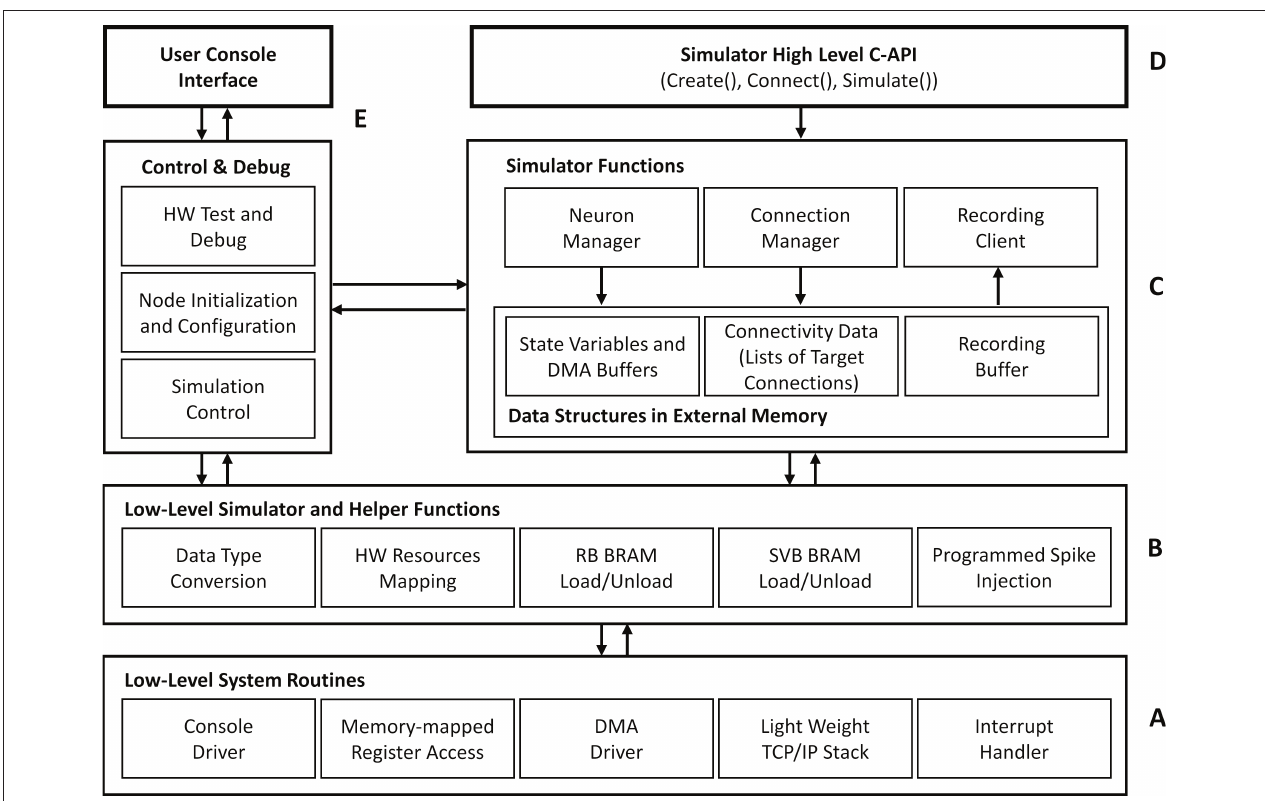
FIGURE 7 | HNC node software system architecture. The tiered architecture provides abstraction at different functional levels. (A) The low-level system routines hide technical details about the operation of the implemented hardware components. Based on this, low-level simulator and helper functions (B) form the foundation for the core component of the HNC node software (C) , that is, the simulator functions. (D) At the highest level, a minimal set of functions is provided to instantiate and simulate a network. (E) In addition, the software system implements components that are responsible for control, testing, and debugging and also enable user